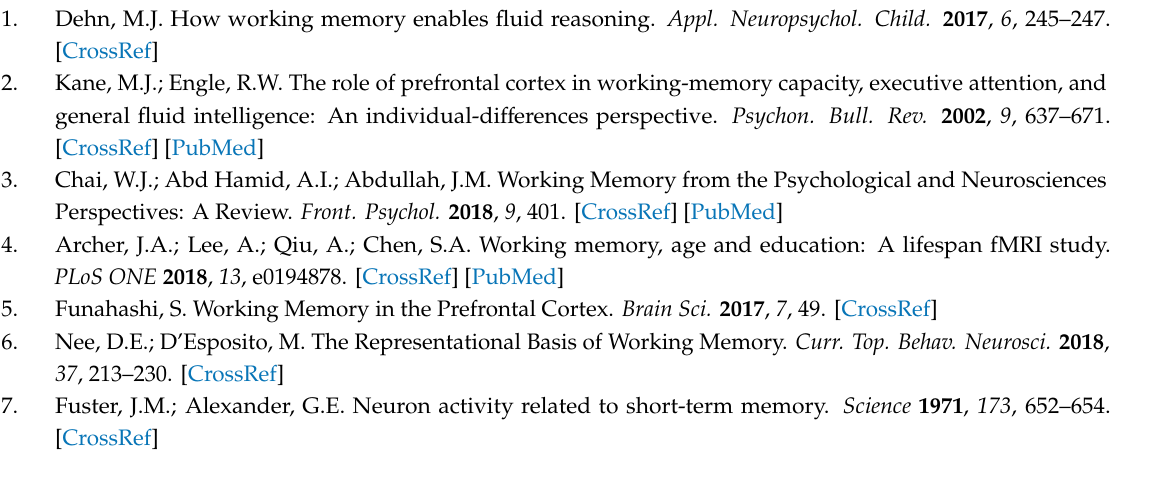
Figure S1: Scores of the n-back test with verbal stimuli ( n = 2) before and after rTMS. Figure S2: Scores of the n-back test with spatial stimuli ( n = 2) before and after rTMS. Figure S3: Scores of the n-back test with verbal stimuli ( n = 3) before and after rTMS. Figure S4: Scores of the n -back test with spatial stimuli ( n = 3) before and after rTMS. Figure S5: Scores of the SSP test before and after